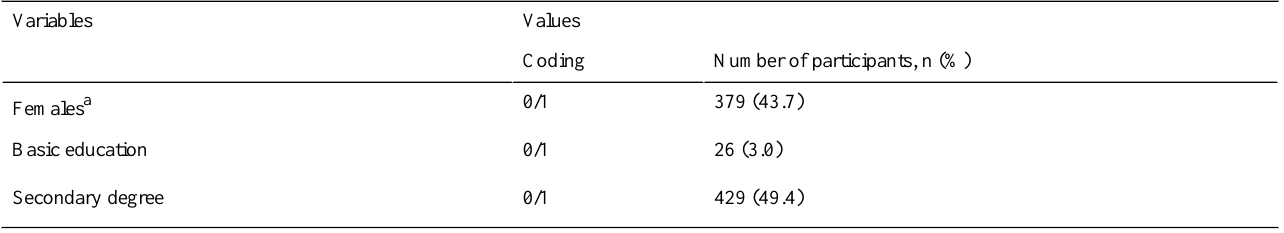
Table 2. Descriptive statistics of the study variables: categorical